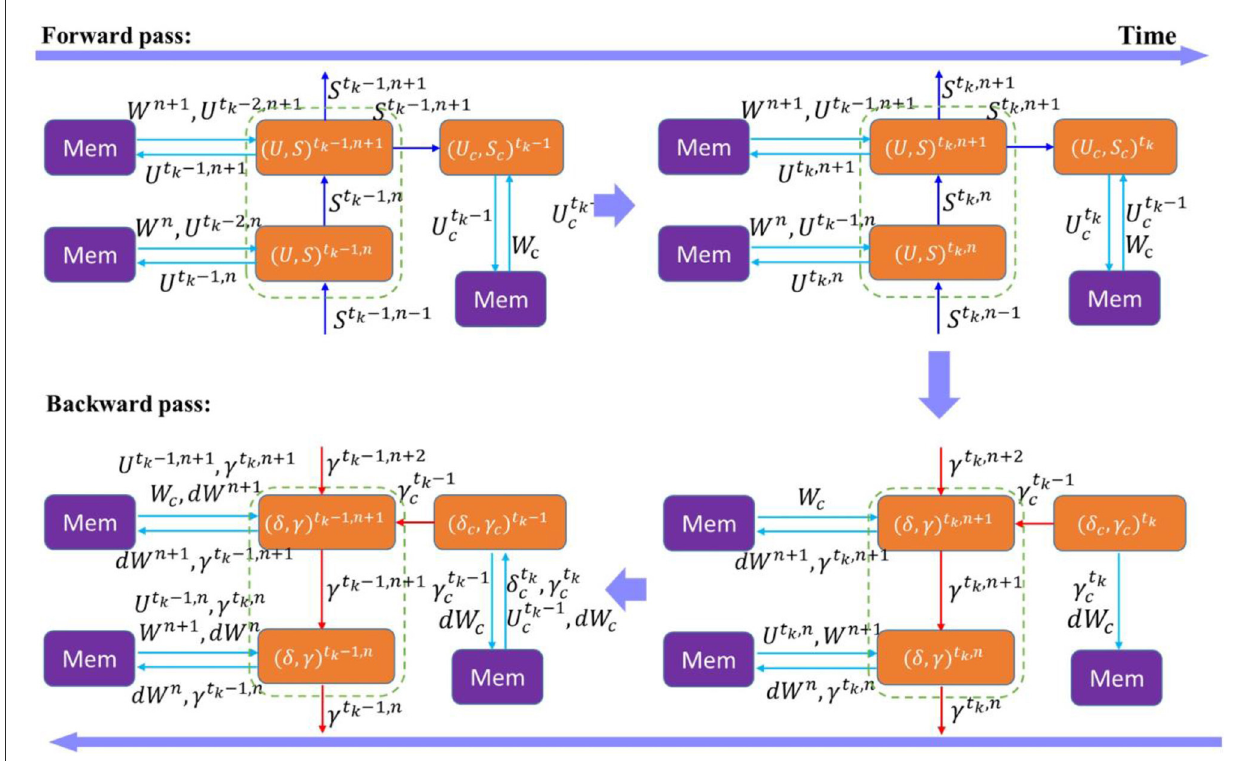
FIGURE8 Memory traffic of forward pass and backward pass in a local learning block during a truncation interval. ( U , S ) t , n represents the neural states in the layer n of the main network at time t. W n and dW n are the weights and gradients in the layer n. (δ , γ) t , n represents the spike error and potential error in the layer n at time t. The parameters and states of the local classifier are indicated by the subscript c. t k is the end of the truncation interval.